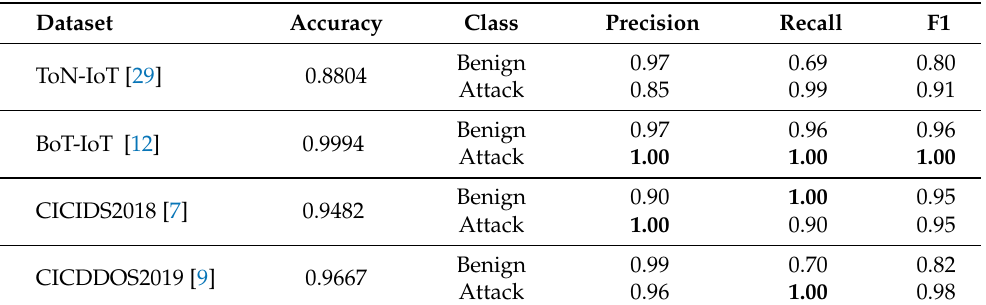
Table 4. Performance of binary classifiers trained by CICIDS2017 dataset and tested on four other datasets.